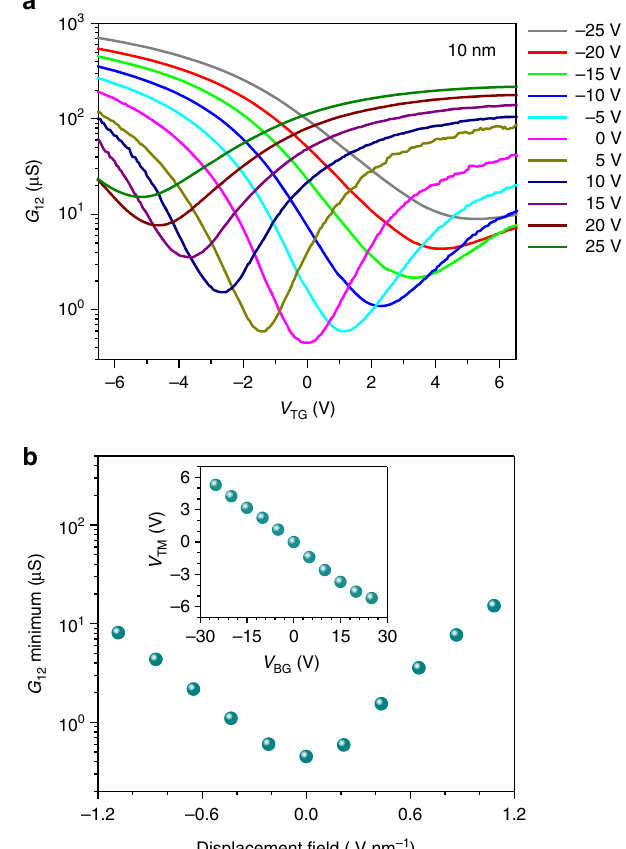
Figure 3 | Bandgap tuning in a 10 nm-thick BP film. ( a ) The 10 nm-thick BP film conductance as a function of top gate bias ( V TG ) at different static back gate biases ( V BG ) from (cid:2) 25 to 25V. ( b ) The minimum conductance at the charge-neutrality point as a function of external displacement field. Inset: the top gate bias at which the minimum conductance occurs ( V TM ) as a function of the back gate bias ( V BG